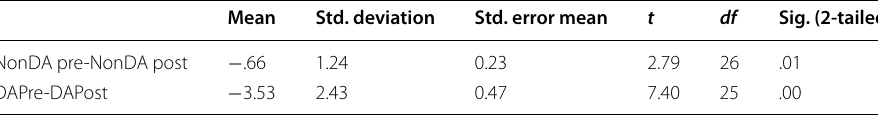
Table 5 Paired samples test (speaking pre‑ and posttests of each group) Mean Std. deviation Std. error mean NonDA pre‑NonDA